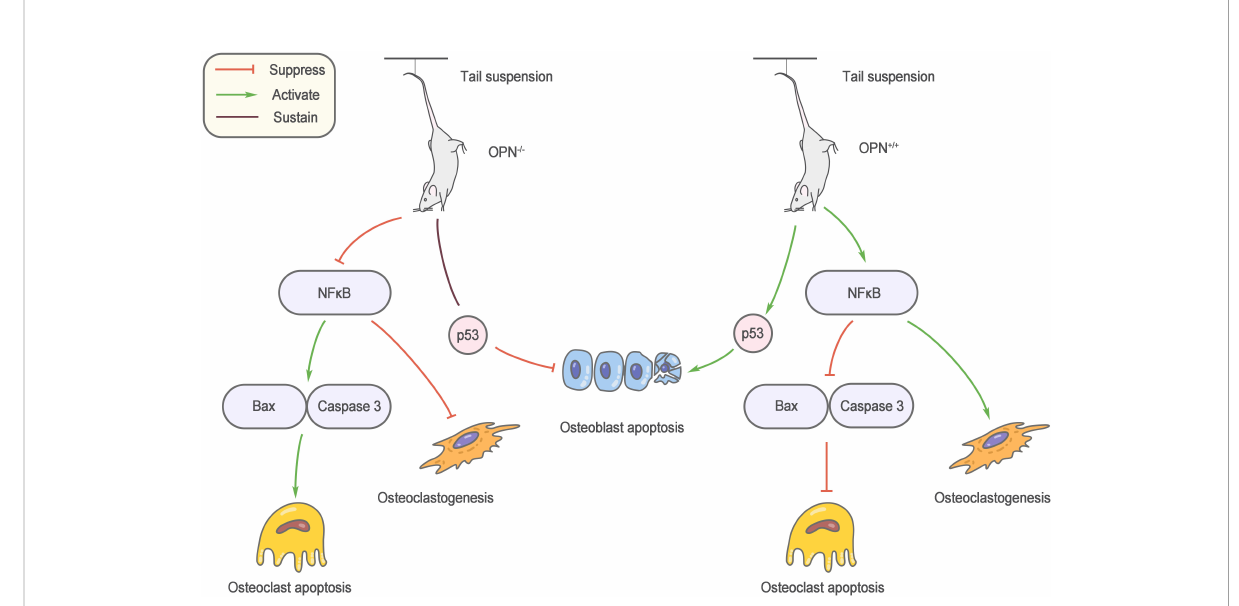
FIGURE 2 Role of OPN in musculoskeletal aging. OPN knockout affects multiple osteoblast and osteoclast regulatory factors during suspension, and nuclear factor kappa B (NF- k B)-mediated osteoclastogenesis and apoptosis inhibition are regulated by